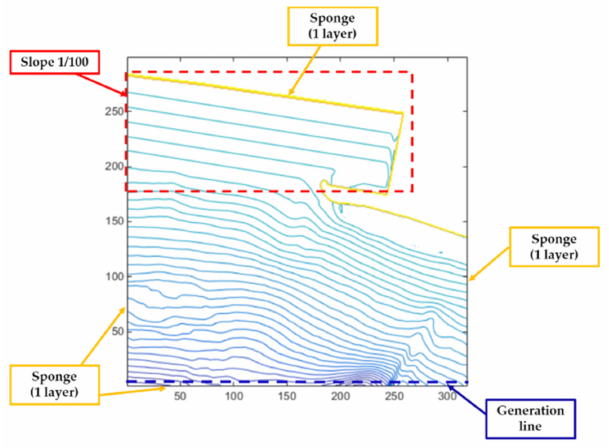
Figure 17. Model setup of case study bay.